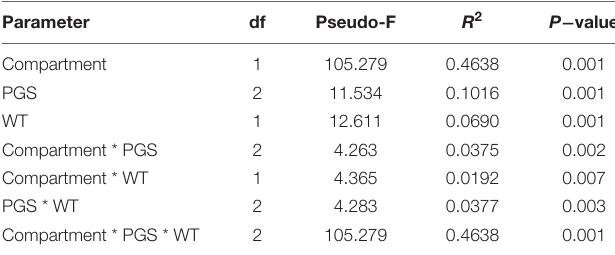
TABLE 1 | The relative importance of soil-plant compartment, plant growth stage (PGS) and watering treatment (WT) for the total bacterial community structure associated to the samples investigated in this study as revealed by